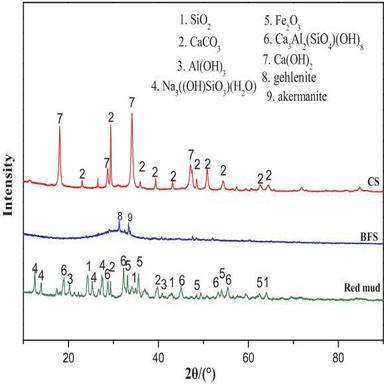
XRD patterns of RM, BFS and CS.